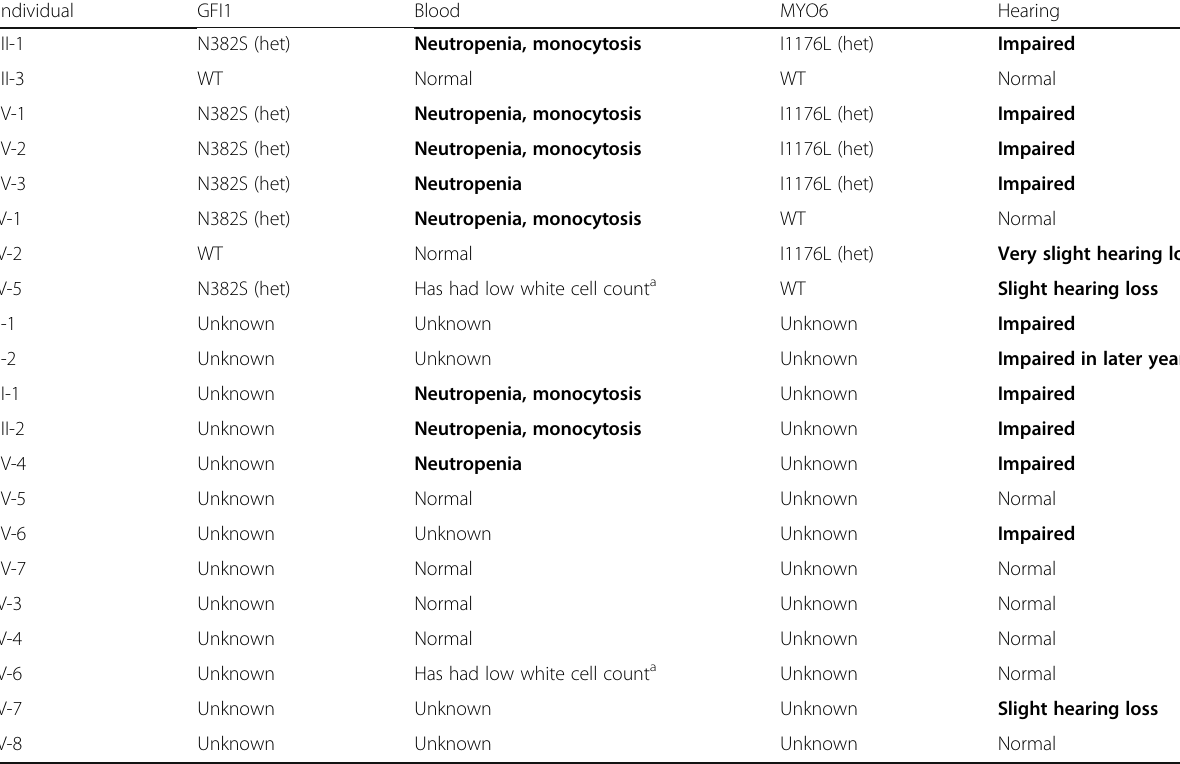
Table 1 Genotypes and phenotypes of various members in the family